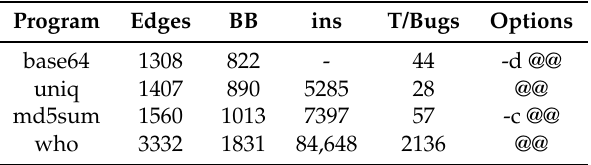
Table 1. LAVA-M dataset